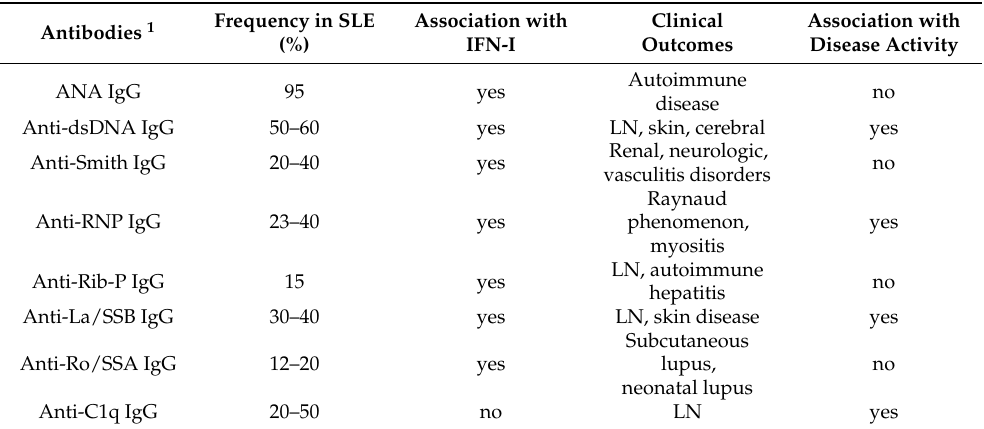
Table 2. Autoantibodies in systemic lupus erythematosus (SLE) and their association with the type I interferon signature (IFN-I), clinical outcomes, and disease